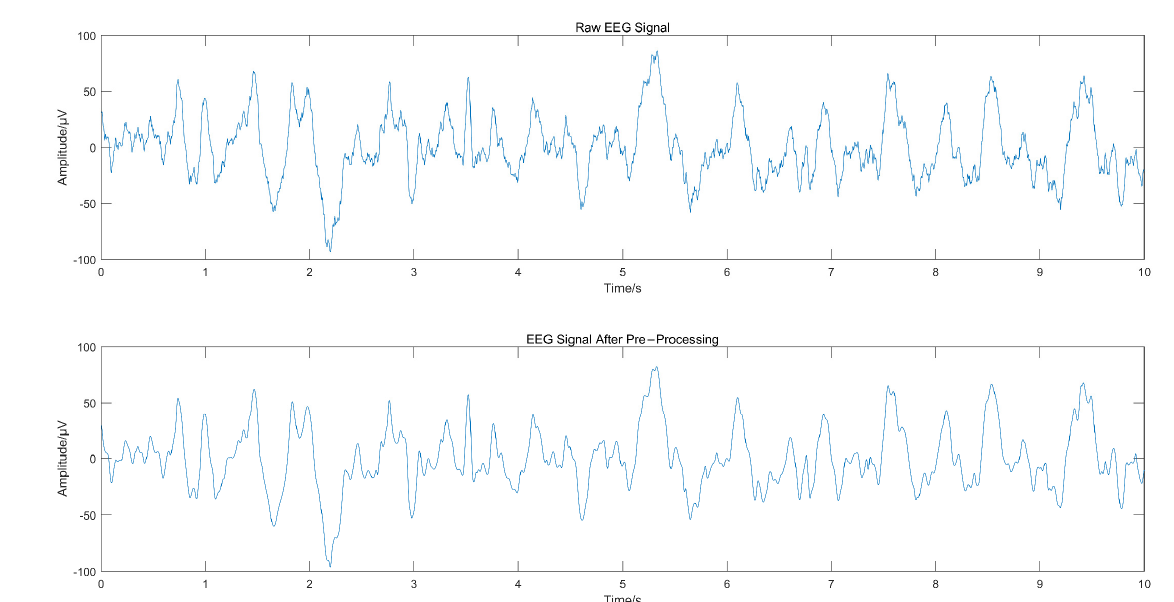
Figure 3. Comparison of EEG signal before and after pre-processing.